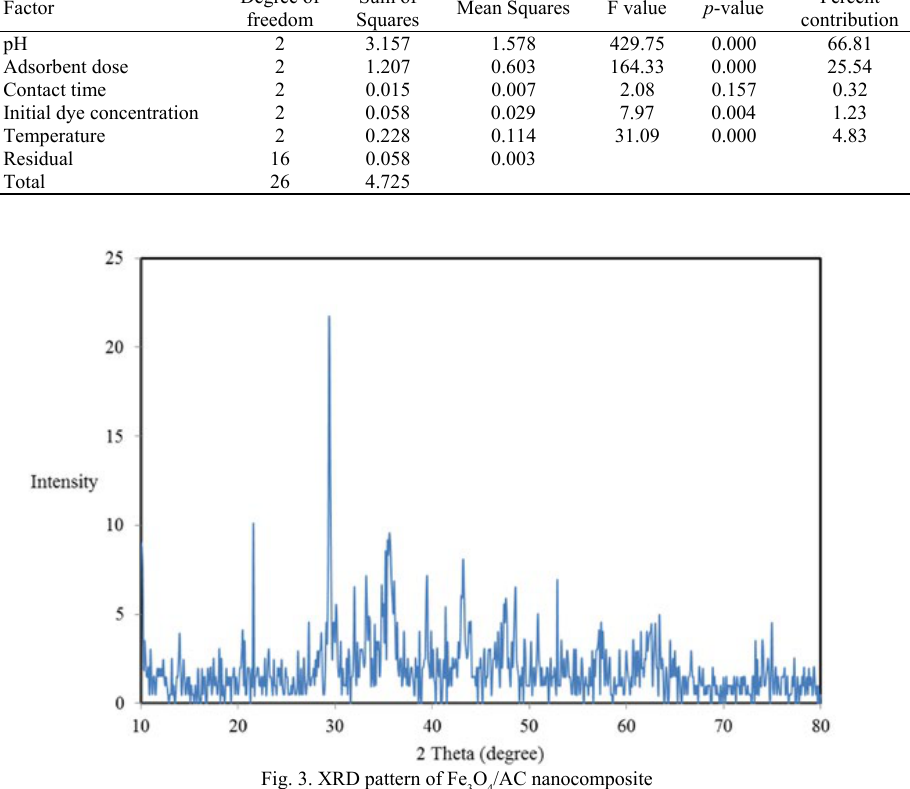
Fig. 3. XRD pattern of Fe